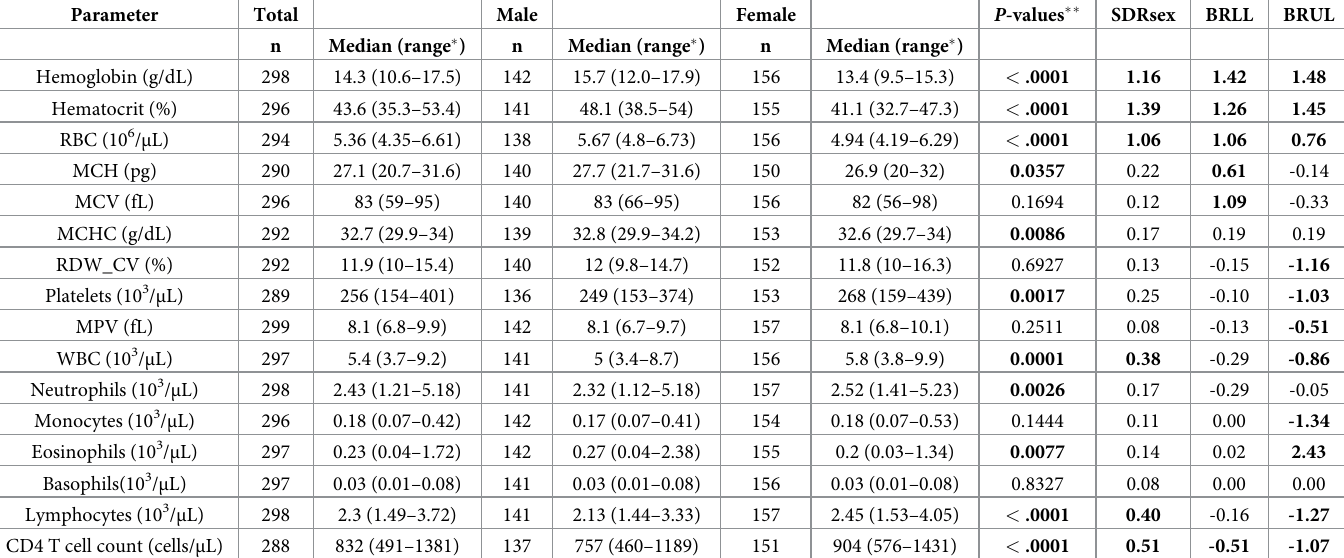
Table 1. Hematological reference intervals and CD4 absolute count (median and 2.5 th —97.5 th percentiles) derived from healthy young adults in Kisumu County.